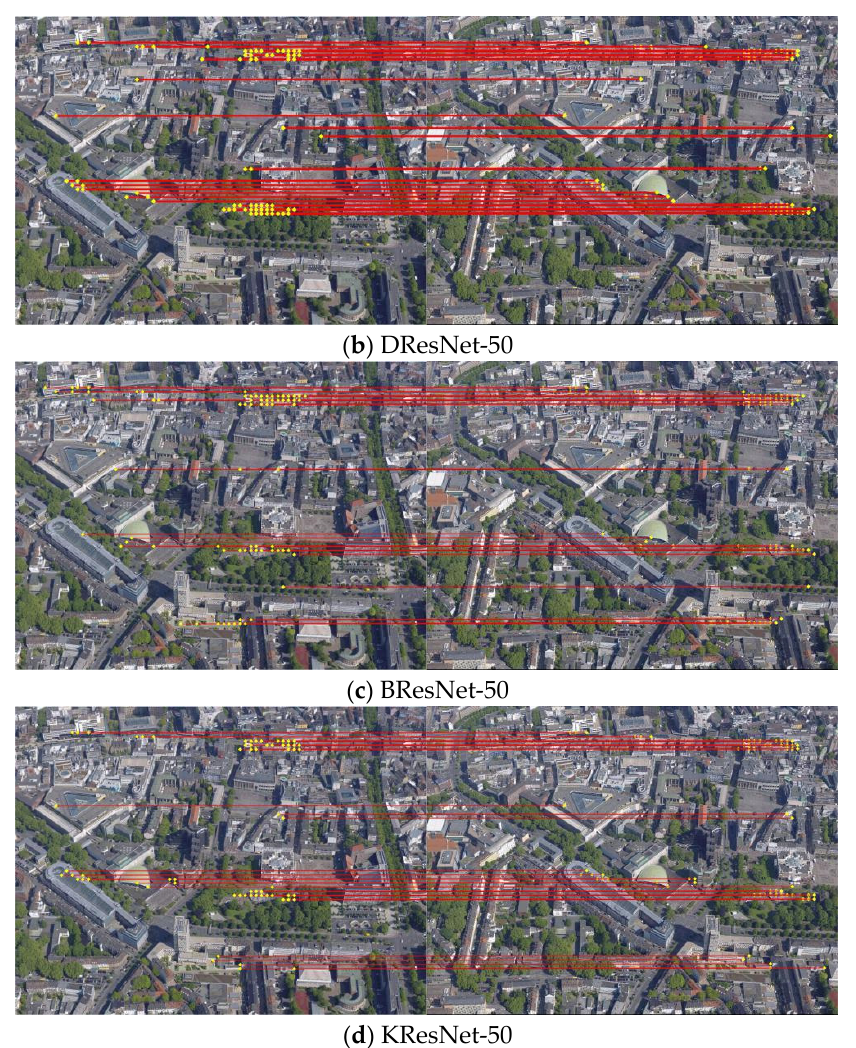
Figure 5. The matched point pairs for the urban scene image: ( a ) VGG-16, ( b ) DResNet-50, ( c ) BResNet-50 and ( d ) KResNet-50.